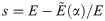
Non-emitting quenching and shifts in FRET transfer efficiency.The relative percentage shift s=E-E˜(α)/E in transfer efficiency is shown when non-emitting quenching occurs as part of the donor-acceptor kinetics.